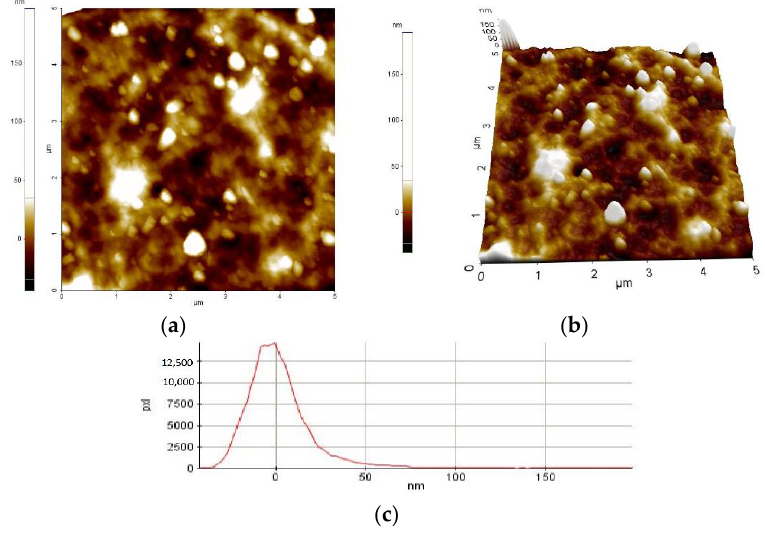
Figure 3. AFM surface topography of AlCrN coating: ( a ) 2D image; ( b ) 3D image; ( c ) region histogram.